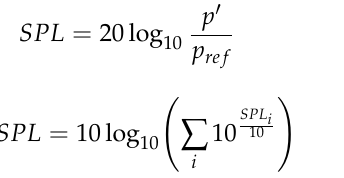
Figure 12. Direction diagram of OASPL on Plane XZ.